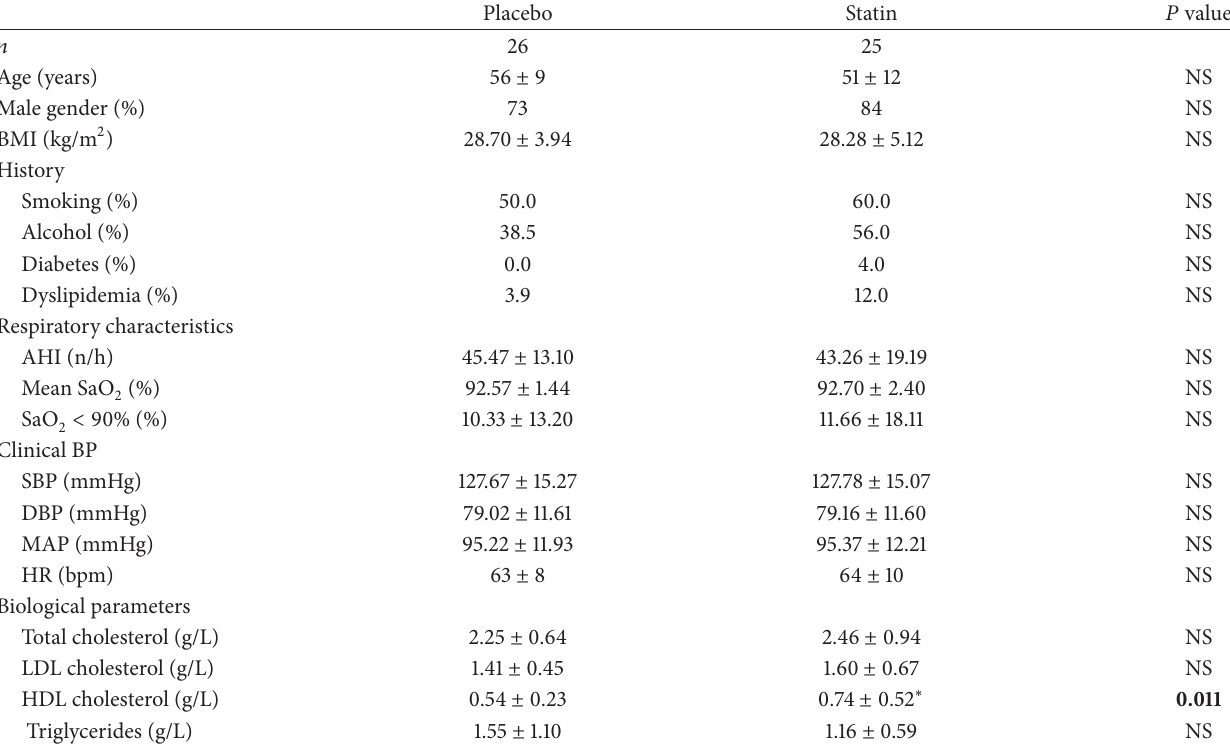
Table 1: Baseline characteristics of placebo and statin